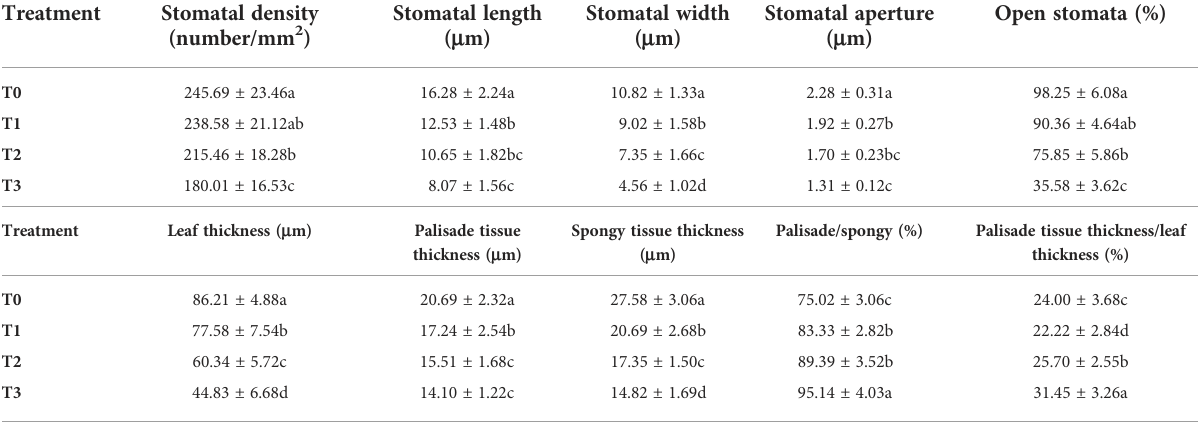
TABLE 2 The main effects of light intensity on leaf stomata and leaf section characteristics of C. betulus .